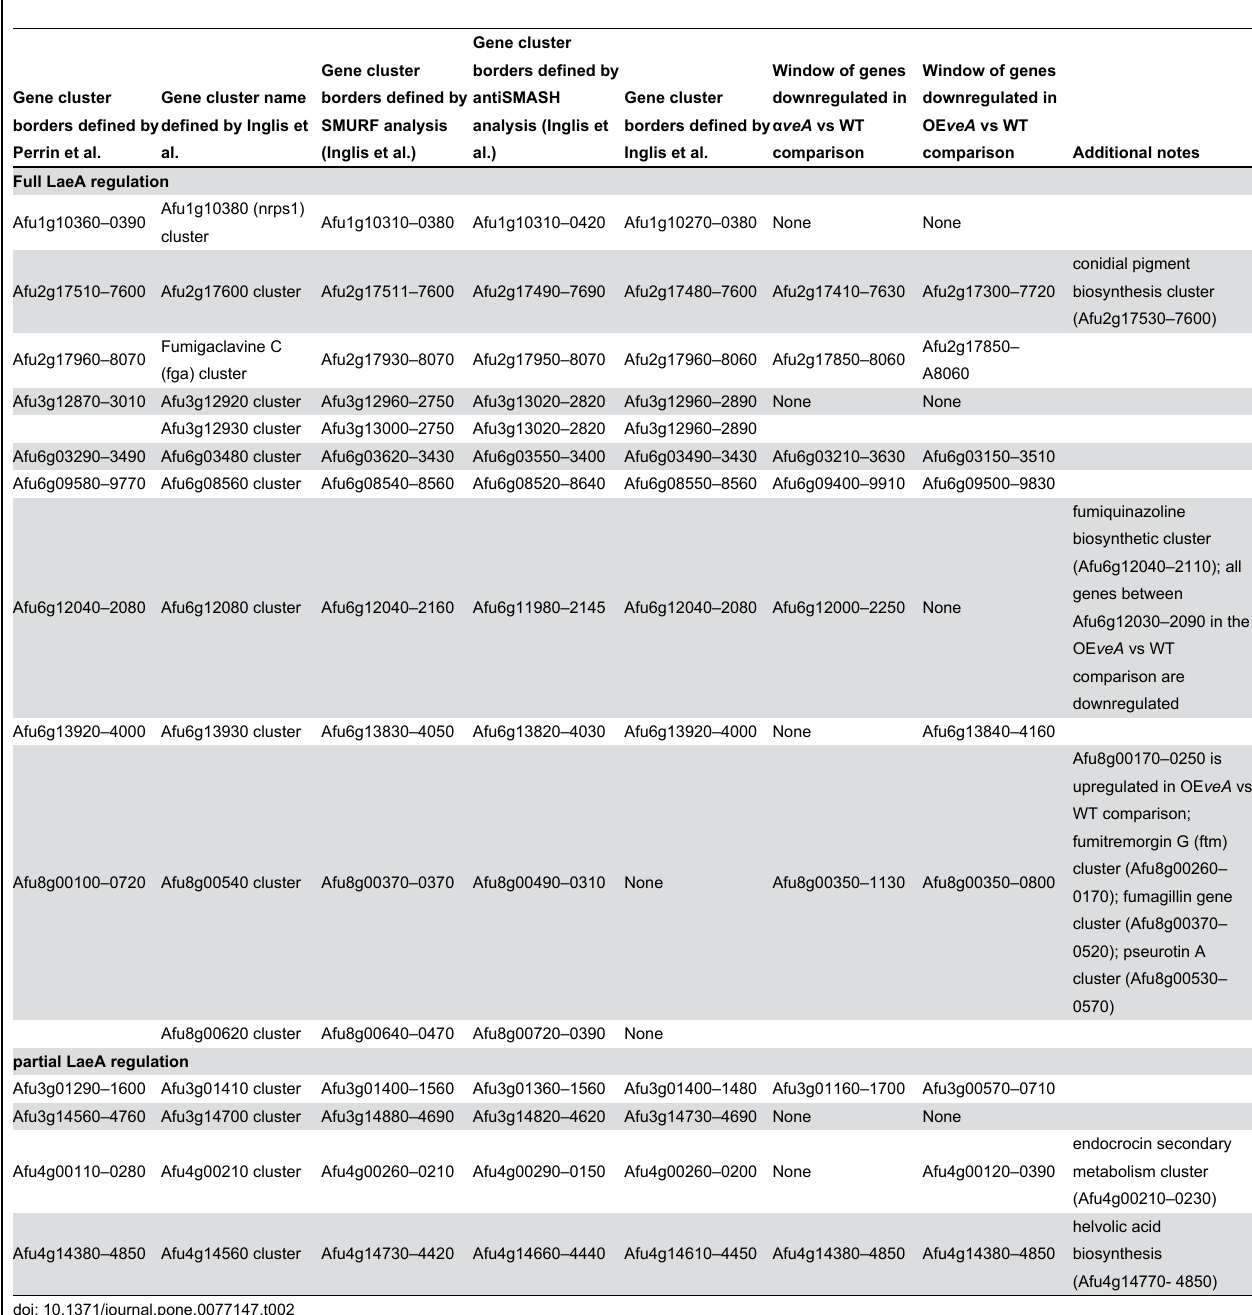
Table 2. The correspondence between gene clusters defined in the studies by Perrin et al. and Inglis et al. with our sliding window